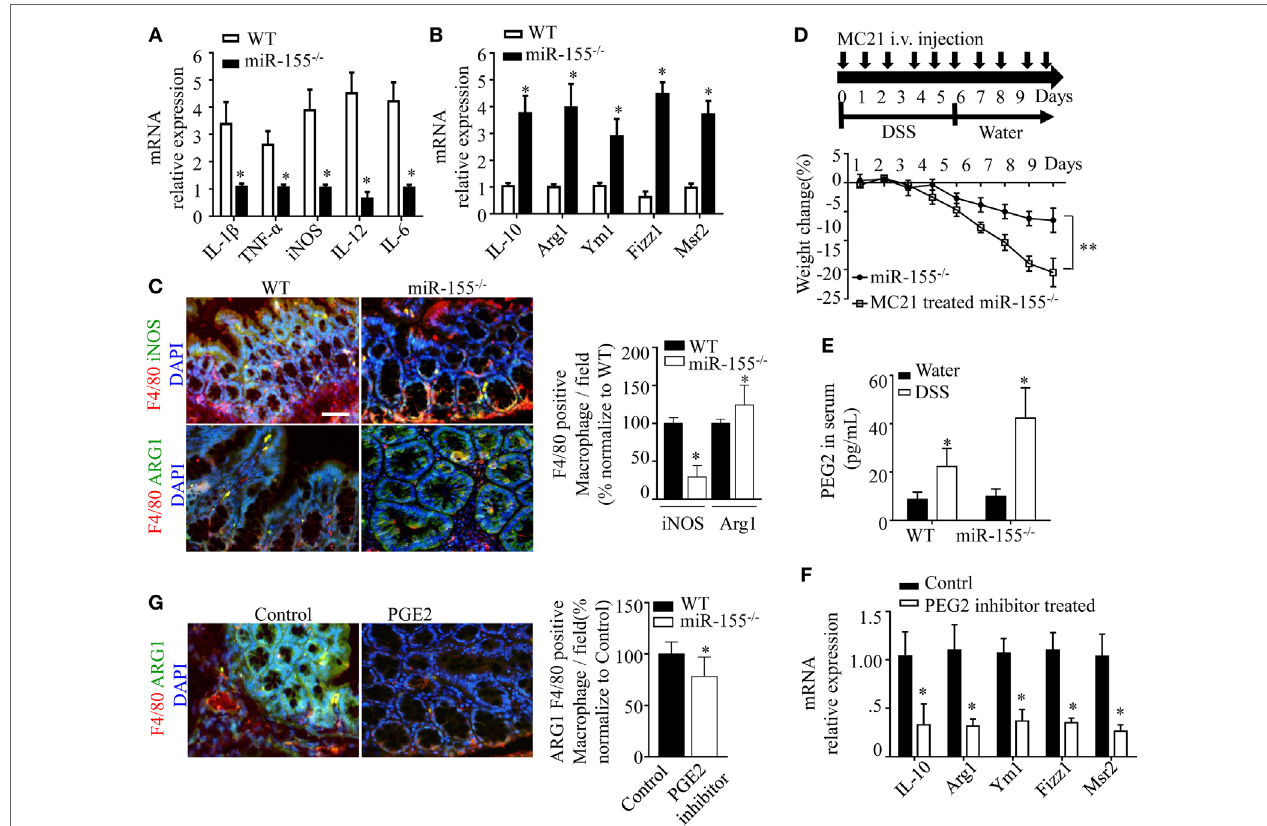
FigUre 4 | miR-155 ablation suppresses M1 polarization and reciprocally promotes M2 phenotype in dextran sulfate sodium (DSS)-induced colitis. (a–c) Total RNA was isolated from colon tissues of WT ( n = 5) or miR-155 − / − ( n = 5) mice that were given 3% DSS in drinking water for 5 days, followed by regular drinking water for 6 days. The relative expression of mRNA associated with M1-polarized macrophages (a) and M2-polarized macrophages (B) was measured by Q-PCR. (c) Representative immunofluorescence images (left) and the quantification (right) of M1 and M2 in colon tissues co-stained with macrophage F4/80 (green), iNOS/ Arg1 (red), and DAPI (nuclei, blue). (D) In miR-155 − / − mice ( n = 8), depletion of Ly6C hi monocytes in the blood was achieved using MC21 antibody during DSS colitis induction as the schematic protocol indicated (up) resulted in aggravated DSS symptoms (down). (e) Serum levels of PEG2 in WT ( n = 5) and miR-155 − / − ( n = 5) mice at day 2 of DSS colitis were determined by ELISA. (F–g) miR-155 − / − mice ( n = 5/group) were i.p. injected with PGE2 inhibitor at DSS treatment days 1, 3, and 5. The relative expressions of M2 genes were measured by Q-PCR (F) , and the number of M2(F4/80 + Arg1 + ) was determined by immunofluorescence (g) . * P < 0.05 vs WT control [Student’s t -test in (a–g) ]. Data are representative of two or three independent experiments (mean and SD). ns, not significant; WT, wild-type; CBA, cecal bacterial antigen; Arg1,